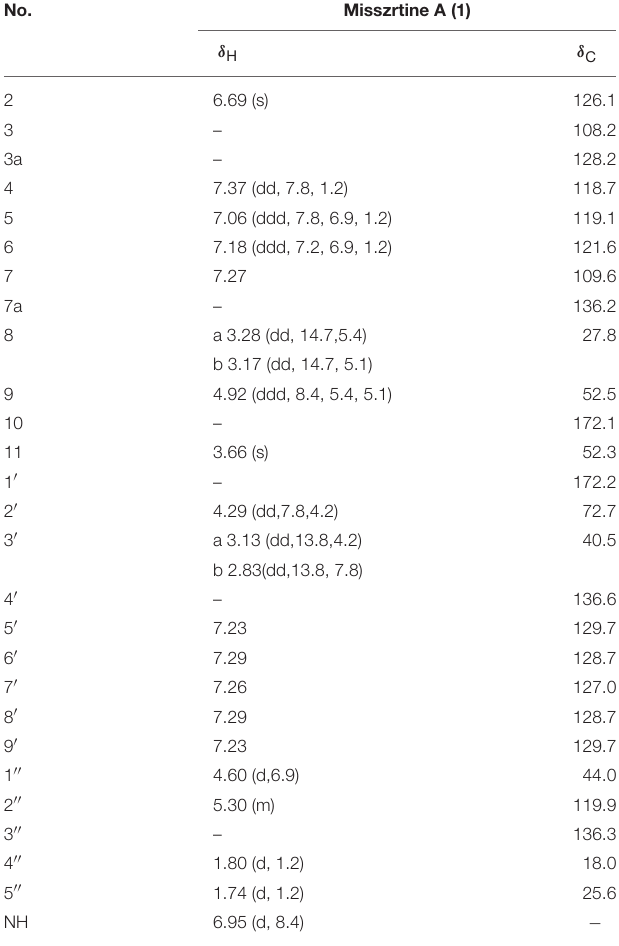
TABLE 1 | 1 H and 13 C NMR spectral data of 1 ( J in Hz, in CDCl 3 ) a .